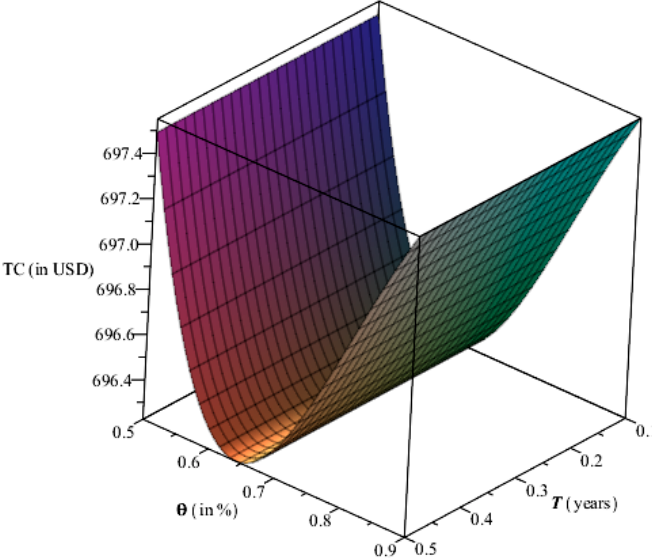
Figure 7. The total cost function’s convexity behavior for α > 0 and c p > h c .